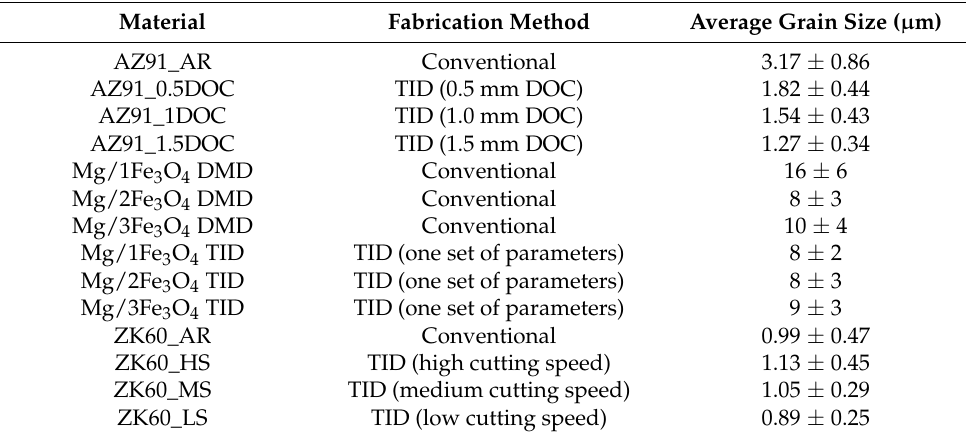
Table 6. Average grain sizes of Mg materials undergoing both conventional and TID method processing